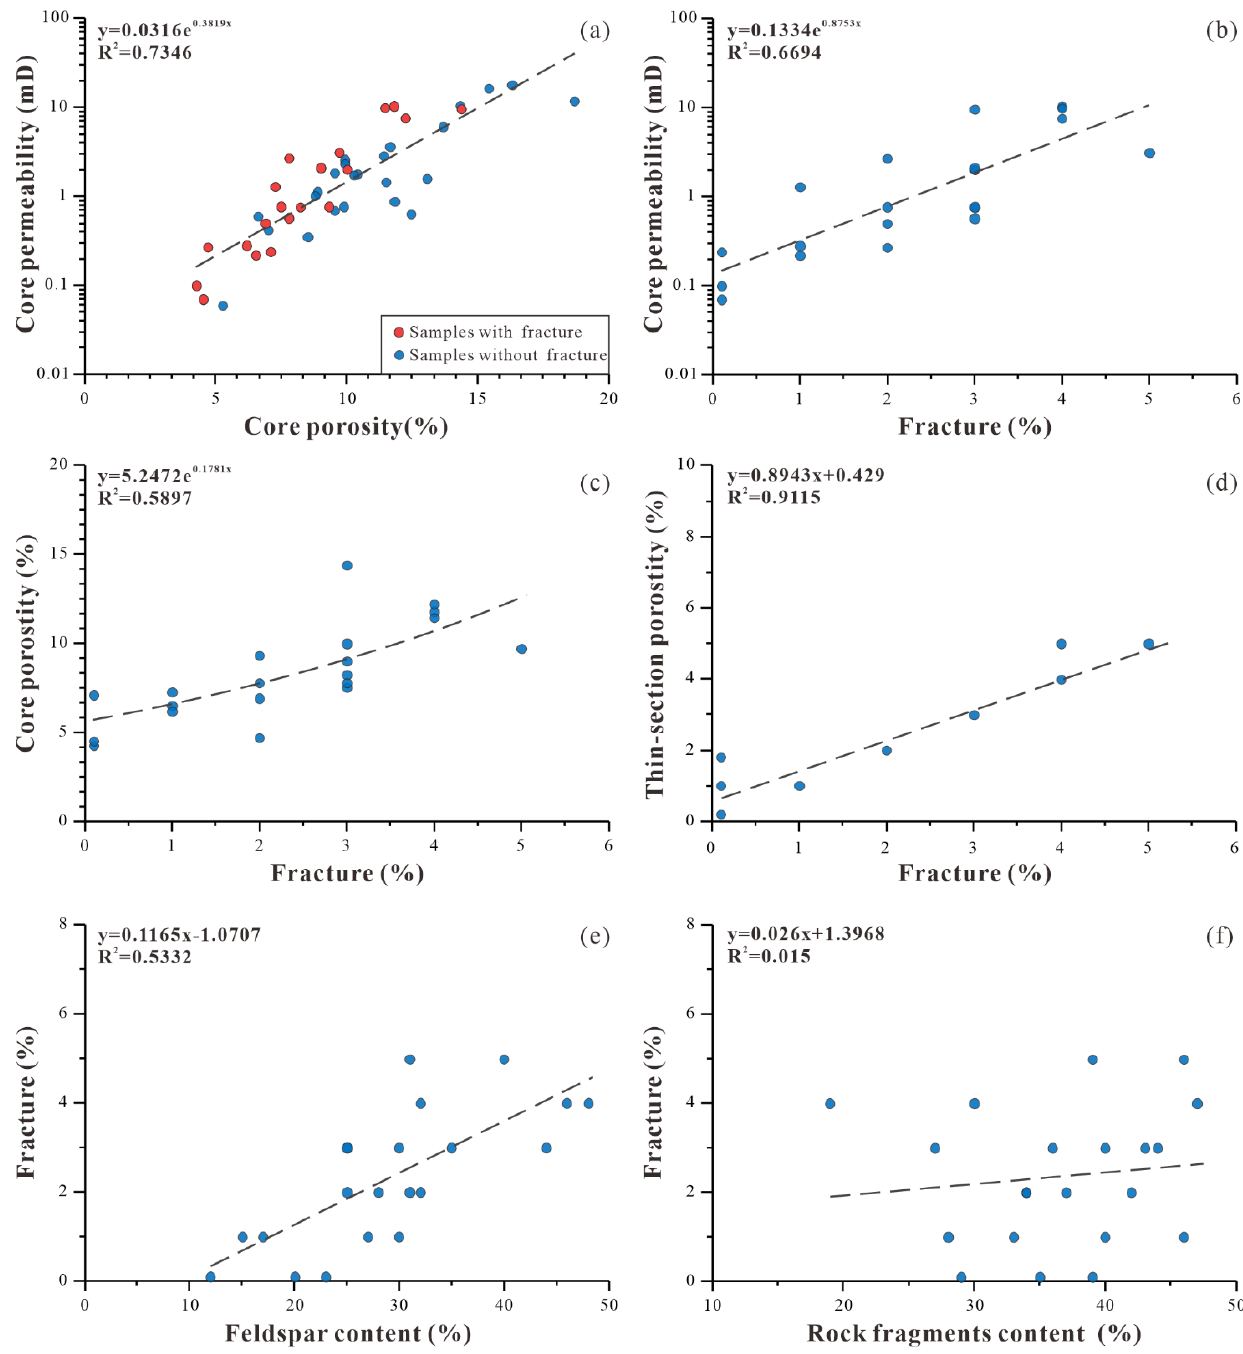
Figure 21. Relationship between the fractures and core permeability, core porosity, thin-section porosity, feldspar content, and rock fragment content. ( a ) core porosity and core permeability; ( b ) fracture and core permeability; ( c ) fracture and core porosity; ( d ) fracture and thin-section porosity; ( e ) feldspar content and fracture; ( f ) rock fragments content and fracture.